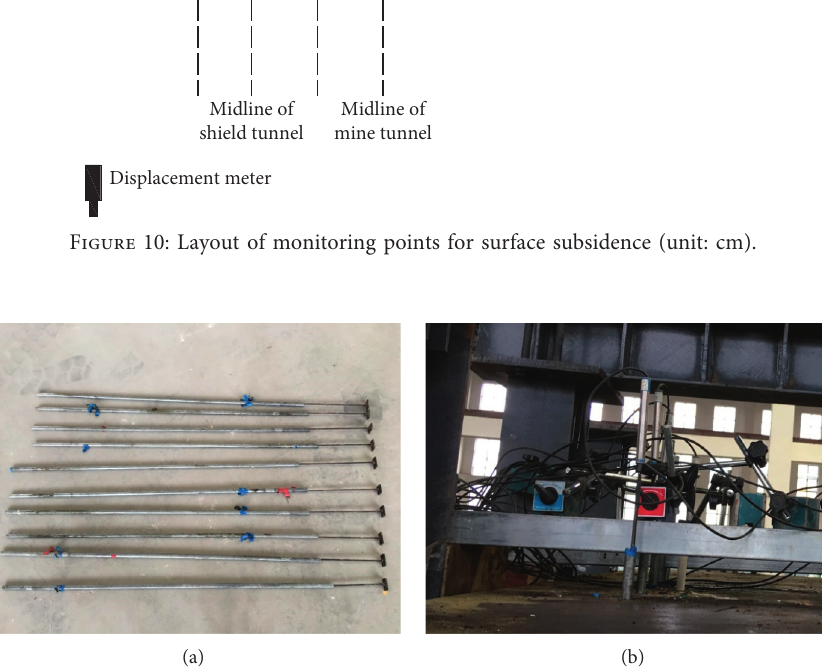
Figure 11: Ground displacement meter and arrangement. (a) Ground displacement meter; (b) arrangement of ground displacement meter.